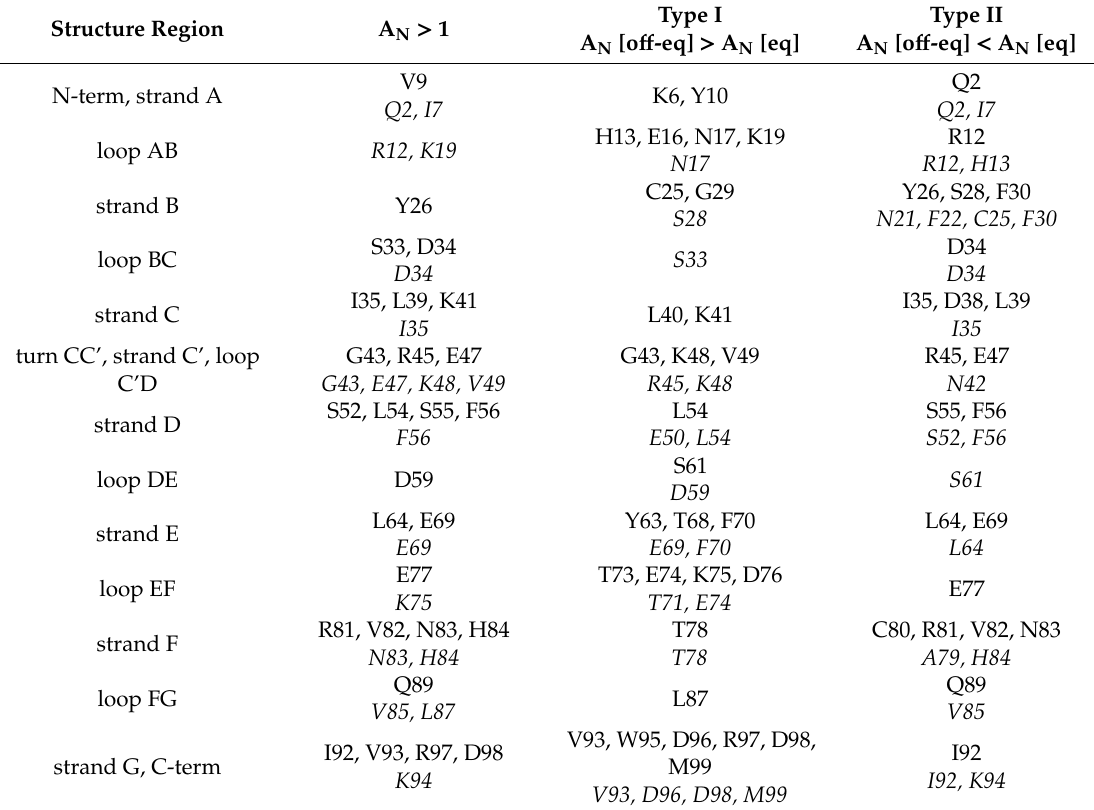
Table 2. Paramagnetic perturbation induced by 0.8 mM Tempol on the amide NMR signals of 8 µ M β 2m. Equilibrium (column 2) and o ff -equilibrium (columns 3 and 4) data are compared to the corresponding data obtained at 50 µ M β 2m and 5:1 Tempol:protein ratio [16] and reported below in italic